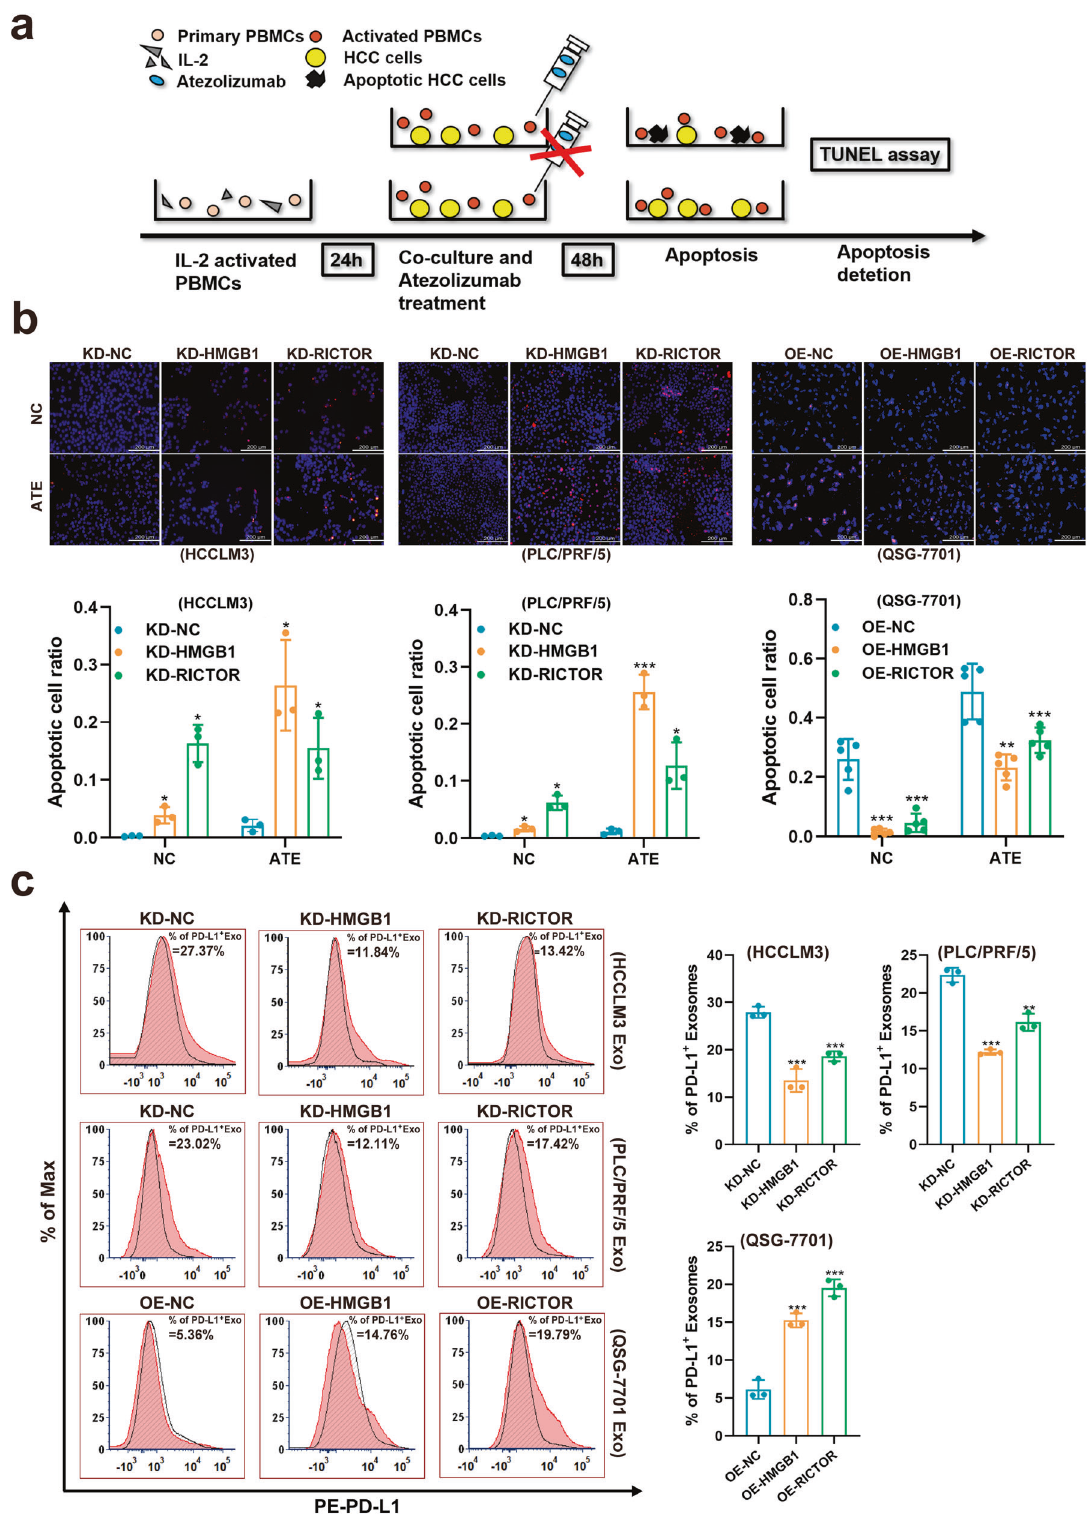
Fig. 5 HMGB1 and RICTOR mRNAs epigenetically impede responses to anti-PD-L1 therapy in HCC through PD-L1 + exosomes activity. a PMBC killing assay scheme. HMGB1/RICTOR mRNA interference HCC cells (abbreviated as “ KD-HMGB1 or KD-RICTOR ” , respectively) were cocultured with activated PBMCs and treated with or without Atezolizumab for 48 h before apoptosis detection. b Cell apoptosis in treated HCC cells was evaluated by TUNEL assay (above). The apoptotic cell ratios were shown (below). c Exosomes isolated from cell culture supernatants in treated HCC cells were determined by fl ow cytometry using PE- fl uorescein-conjugated anti-PD-L1 antibody (red). Isotype matched antibody (PE- fl uorescein-conjugated anti-IgG antibody) was used as gating controls (black). Percentages of PD-L1 + Exo resulted from the relative fl uorescence values gated by isotype controls. Exo: exosomes. ** p < 0.01, *** p <